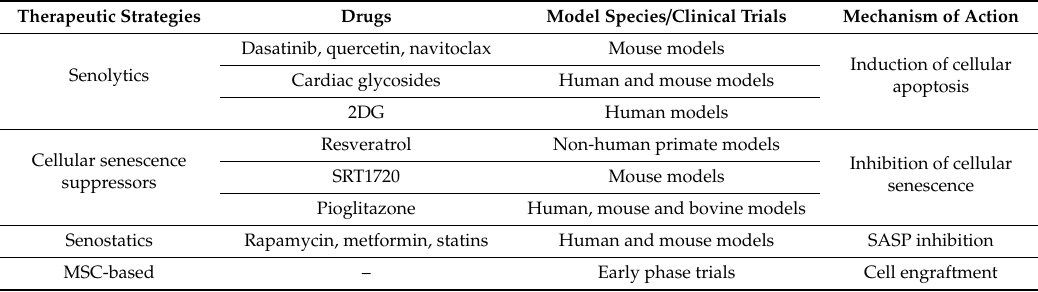
Table 4. Senescence-based therapeutic approaches for atherosclerosis and cardiovascular